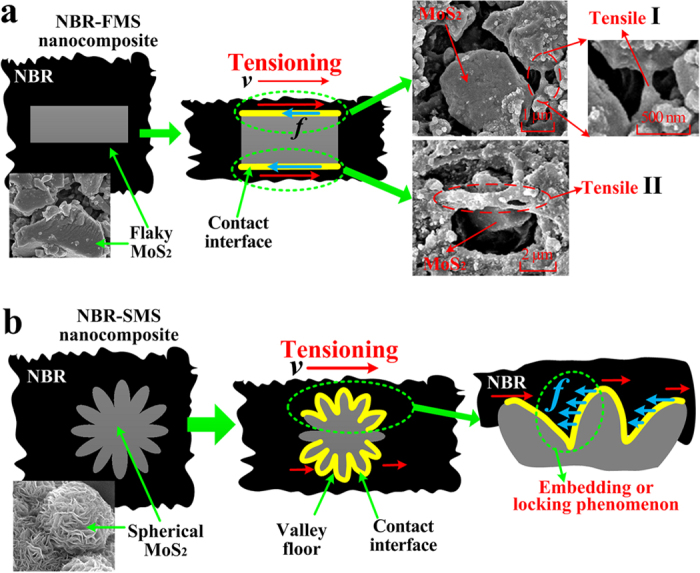
Tension models of (a) flaky MoS2, (b) spherical MoS2 nanoparticles and rubber material.